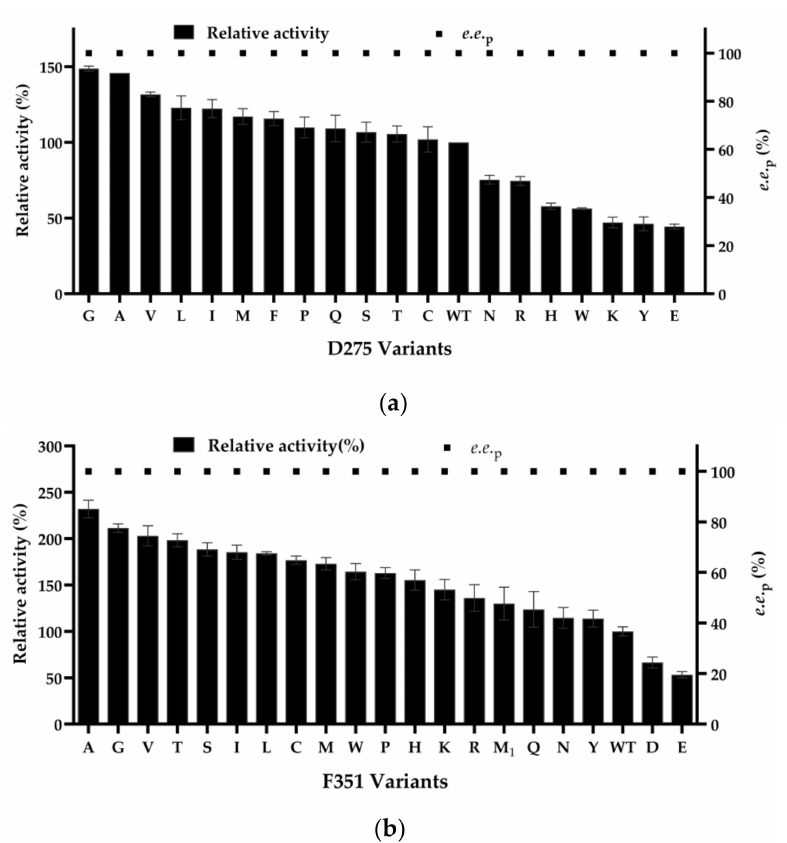
Figure 3. Activity ( a ) and enantioselectivity ( b ) of NemR-PS variants in site-saturation mutagenesis of the residue D275 and iterative saturation mutagenesis of the residue F351. ( a ), the assay mixture consisted of 100 µ g crude enzyme, 20 mM ( E / Z )-citral, 0.4 mM NADPH and 100 mM PIPES buffer (pH 7.0). The activity was measured in triplicate at 30 ◦ C by monitoring changes in the absorbance at 340 nm. The relative activity of 100% represents 0.34 U/mg. ( b ), the reaction mixture consisted of 50 g/L wet cells expressing NemR-PS or its variants, 100 mM ( E / Z )-citral, 300 mM glucose, 50 g/L wet cell expressing BmGDH M6 , 0.12 mM NADP + and 50 mM PIPES buffer (pH 7.0). Constant